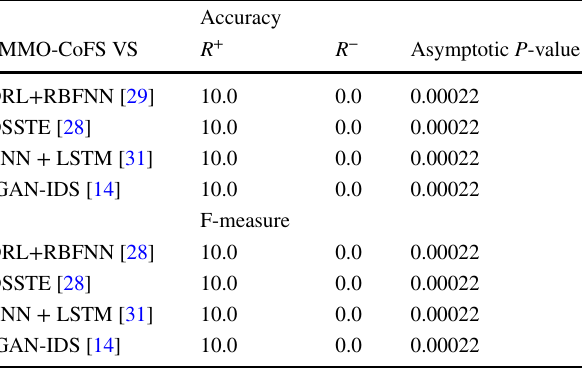
Table 9 The result of Wilcoxon statistical significance test in terms of accuracy and F measure with a significance threshold of 𝛼 = 0.05, R + R − sum of signed ranks and , and P -values